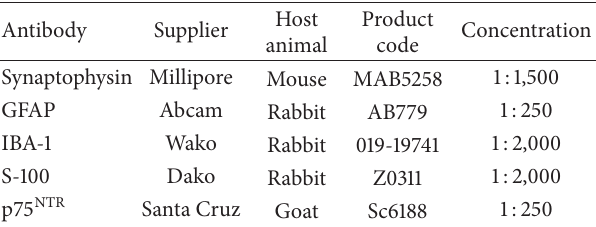
Table1:Primaryantibodiesusedfortheimmunofluorescenceassay. Eachantibodyisfollowedbythesupplier,hostanimal,productcode, and concentration